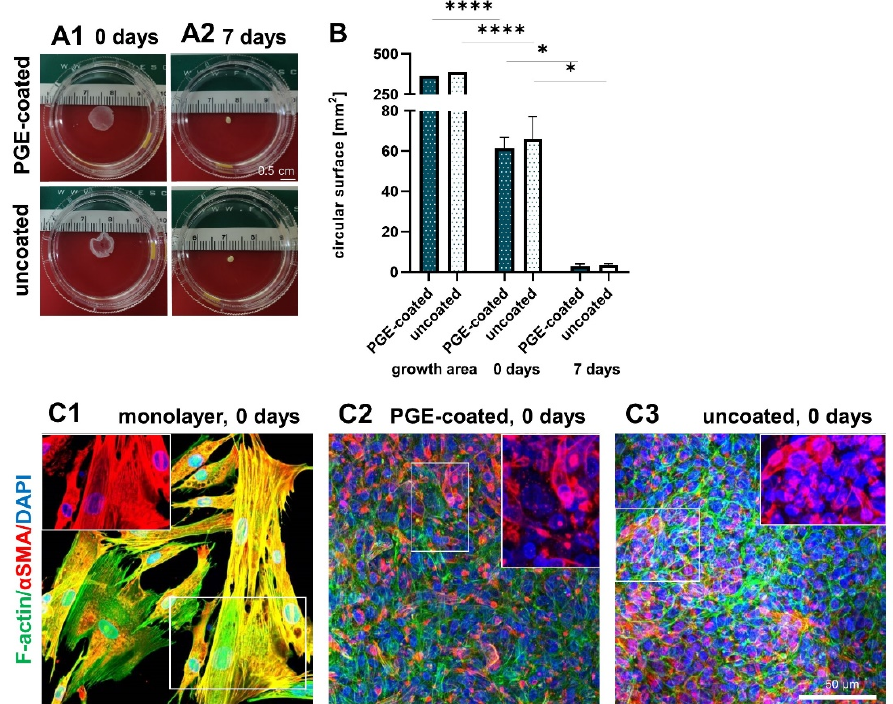
Figure 4. Shape and size of the sheets after detachment (0 d) and when cultured for 7 d. Shape of ligamentocyte sheets after 0 d ( A1 ) and 7 d ( A2 ) transferred to a Petri dish. ( B ) Circular surface of sheets released from poly(glycidyl ether) (PGE)-coated and uncoated plates after 0 and 7 d in comparison to the growth area of one well of the respective 12-well plate. n = 3 independent experiments with ligamentocytes of three different donors. ( C ) F-actin (green) and α SMA (red) of the monolayer ( C1 ) and sheets released from PGE-coated ( C2 ) and uncoated ( C3 ) plates. The insets show exclusively α SMA at higher magnification (red). Cell nuclei were counterstained using 4’,6-diamidino-2-phenylindole (DAPI, blue). Scale bars: 0.5 cm ( A1 – A3 ), 50 µm ( C ). ( B ) Statistic: unpaired one-way ANOVA (comparison between the groups) (*). p values: * <0.05, **** <0.0001.